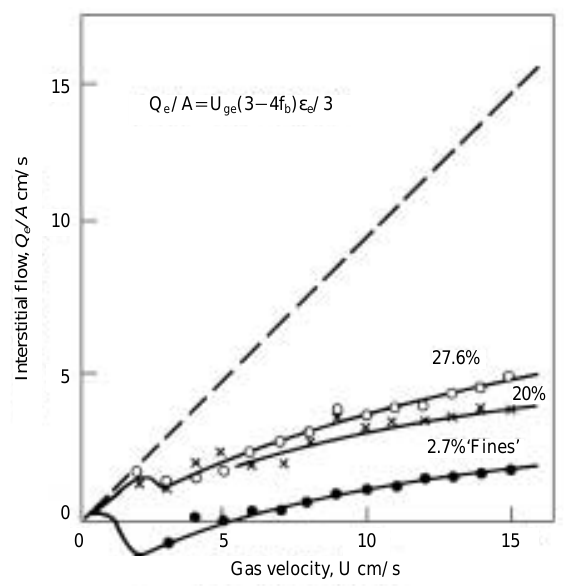
Variation of emulsion-phase gas flow with superficial gas velocity